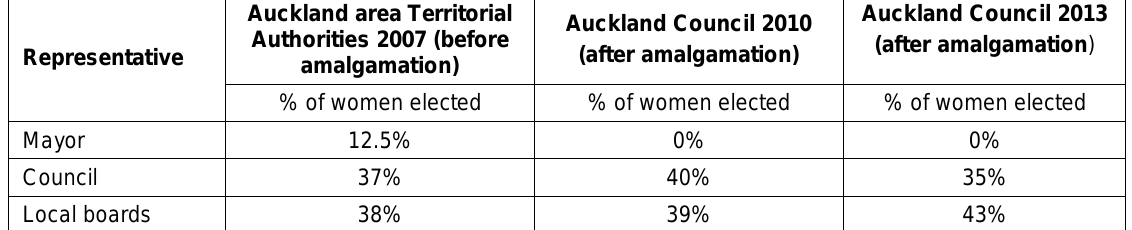
Table 2: Women’s local government representation in Auckland before and after